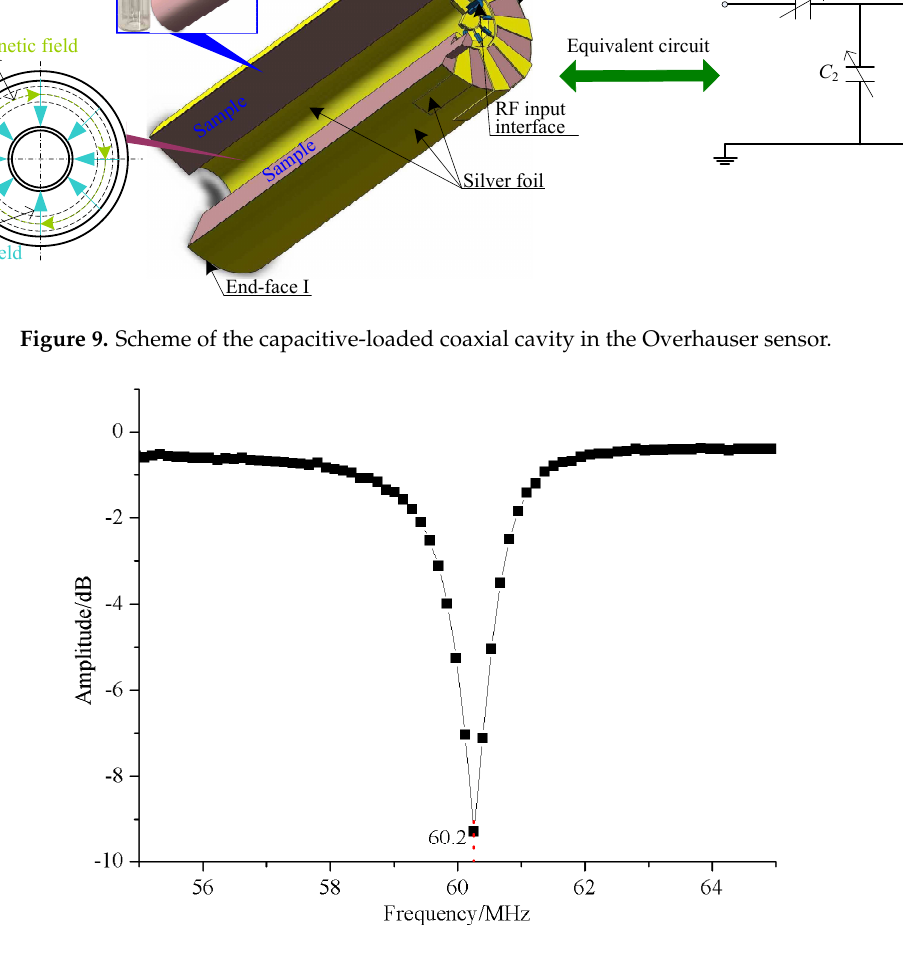
Figure 10. Frequency characteristics of the capacitive-loaded coaxial